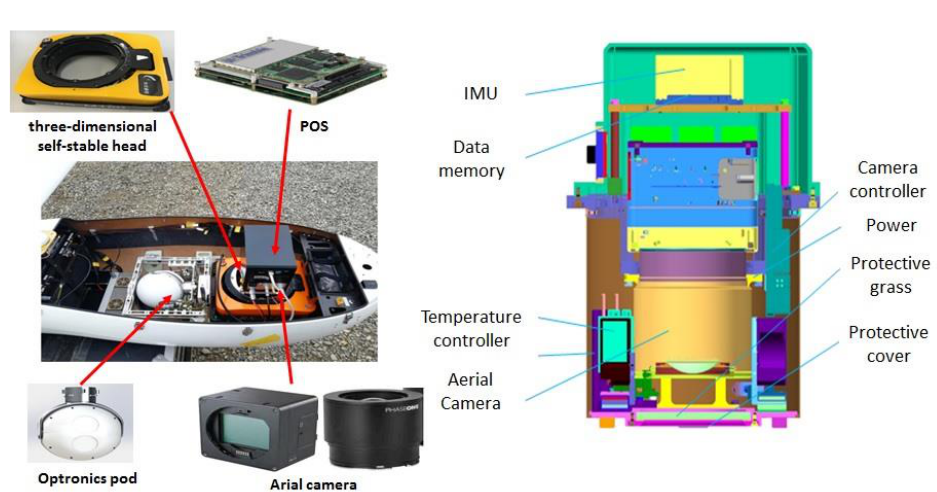
Figure 3. The interfaces of different sensors